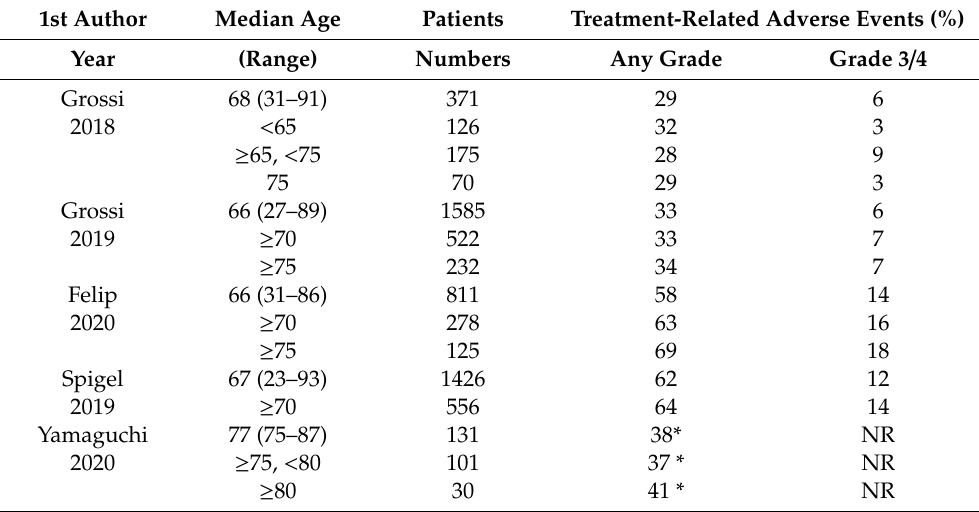
Table 3. Adverse events of elderly vs. non-elderly non-small cell lung cancer patients treated with immune checkpoints